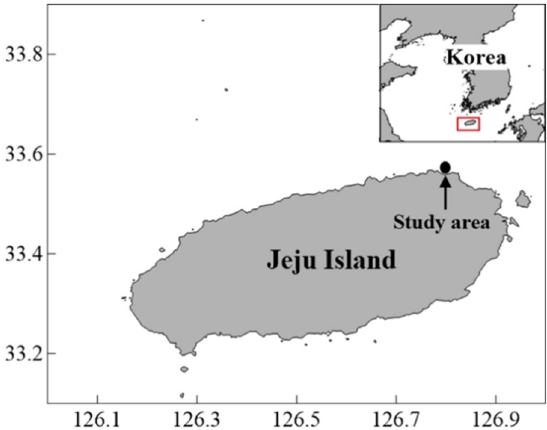
Figure 1. Map showing the study site.